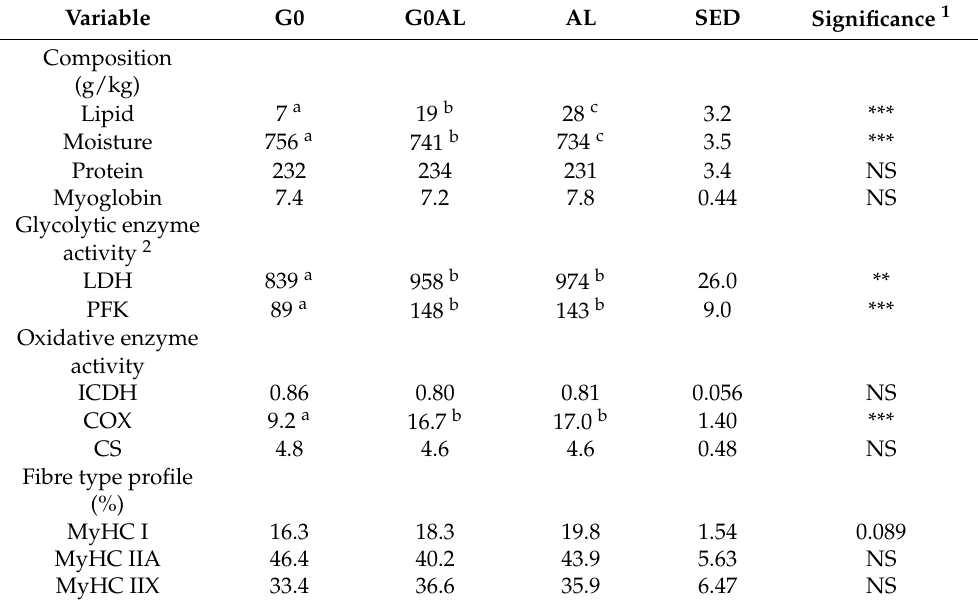
Table 5. Characteristics of the longissimus muscle of suckler bulls slaughtered after: 199 days at pasture (G0); 98 days at pasture followed by 101 days indoors and offered concentrates (G0AL); and 199 days indoors and offered concentrates (AL). AL